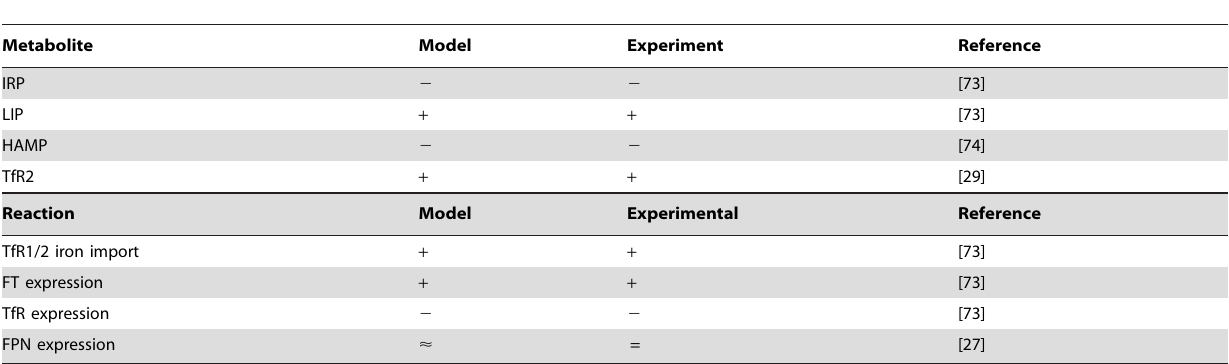
Table 4. HFE knockout validation—The simulation of type-1 hereditary haemochromatosis closely matches experimental findings at steady